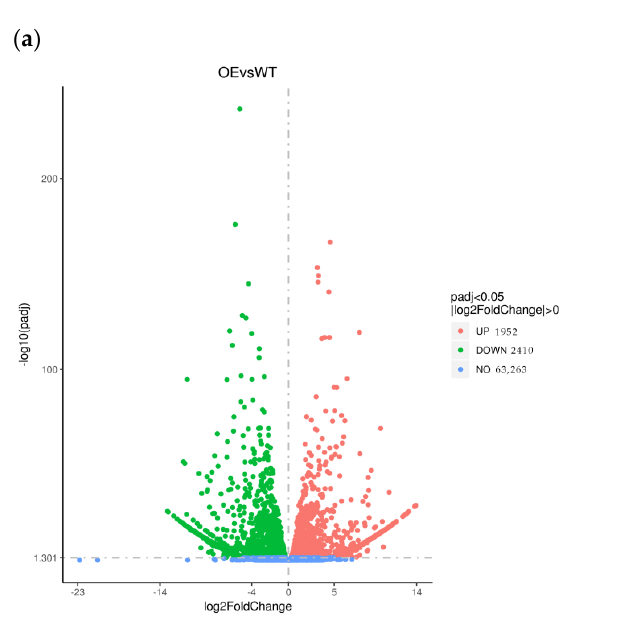
Figure 4. Volcano ( a ) and Venn diagram ( b ) of the significant DEGs between the BnKAT2 -overexpressing (OE) and wild-type (WT) B. napus.